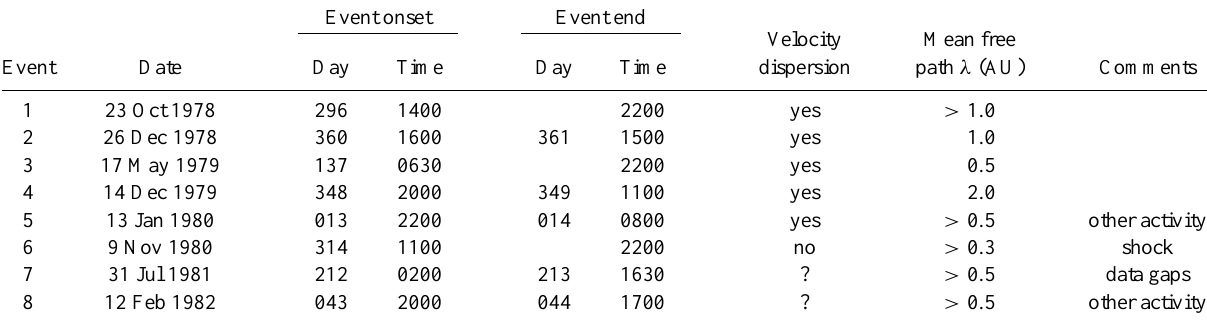
Table 1. 3 He-rich scatter-free events Event onset